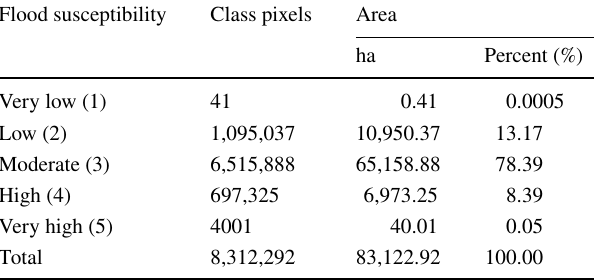
Table 6 Flood susceptibility, area coverage, and